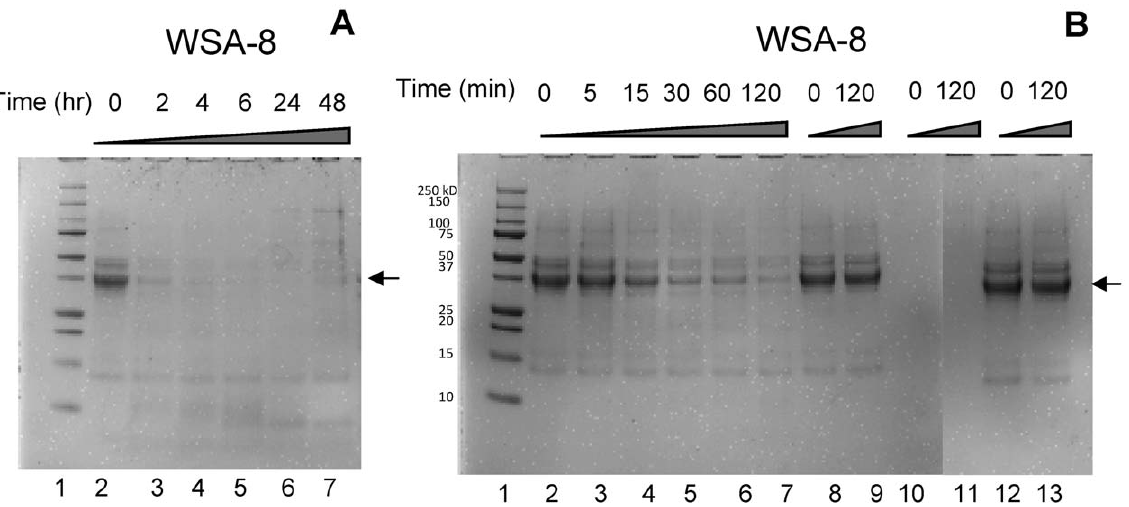
Figure 3. Degradation of gliadins by R.aeria . Gliadin (250 m g/ml) was incubated in a suspension of WSA-8 ( R. aeria ). The final OD 620 was 1.0. Incubation sample aliquots were analyzed by Bis-Tris PAGE. A, lane 1: molecular weight standard; lanes 2–7, WSA-8/gliadin mixtures incubated for 0, 2, 4, 6, 24 and 48 h, respectively. B, lane 1: molecular weight standard, lanes 2–7: WSA-8/gliadin mixture incubated for 0, 5, 15, 30, 60 and 120 min, respectively. Lanes 8 and 9: gliadins incubated for 0 and 120 min in boiled bacterial cell suspensions; lanes 10 and 11: cell suspensions without added gliadins; Lanes 12 and 13: gliadins incubated for 0 and 120 min in saliva ion buffer only. Arrow points to the major protein constituent in the gliadin mixture.